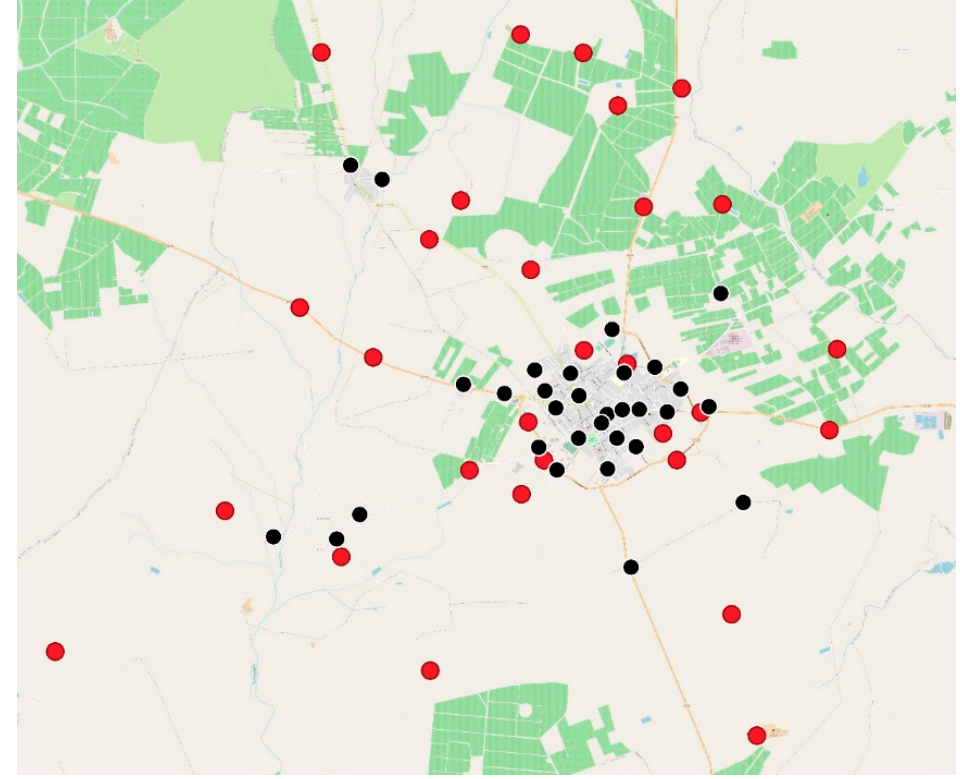
Figure 3. Geographical distribution of the power transformers in Reguengos de Monsaraz. In black are the transformers from which electricity demand data were made available by the DSO, while in red the transformers for which it was not possible to obtain data due to privacy reasons.